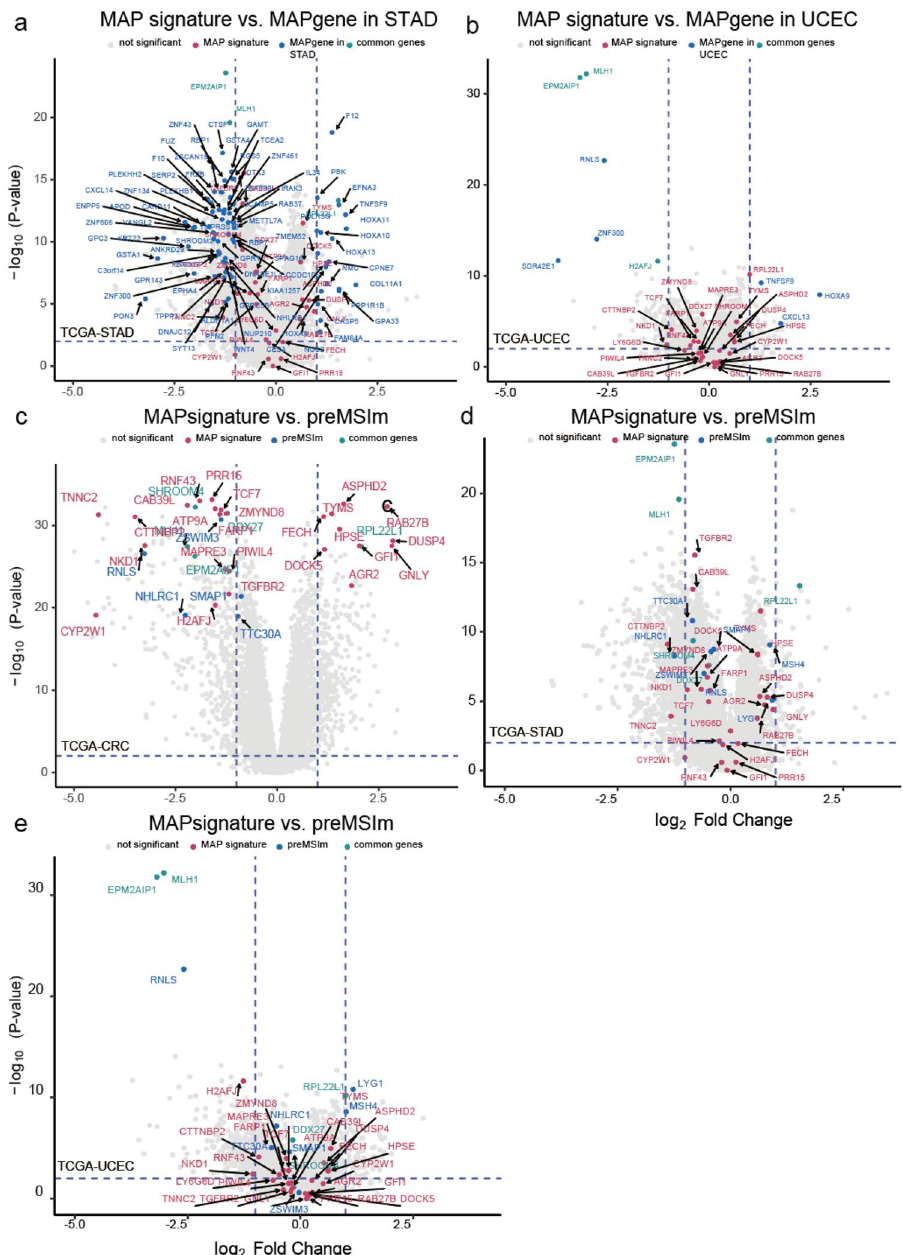
Figure 3. MSI signatures. ( a ) MAP signature and UCEC MSI signature on TCGA-UCEC. ( b ) MAP signature and STAD MSI signature on TCGA-STAD. ( c ) MAP signature and preMSIm signature on TCGA-COADREAD. ( d ) MAP signature and preMSIm signature on TCGA-STAD. ( e ) MAP signature and preMSIm signature on TCGA-UCEC. The x-axis represents log 2 fold changes in gene expression data for MSI versus MSS samples. The colored dots mean the genes of the corresponding signatures marked in each panel. The blue dotted line on the x-axis means − 1 and 1 of the log 2 fold change scale, and 2 (− log 10 (0.01)) on the